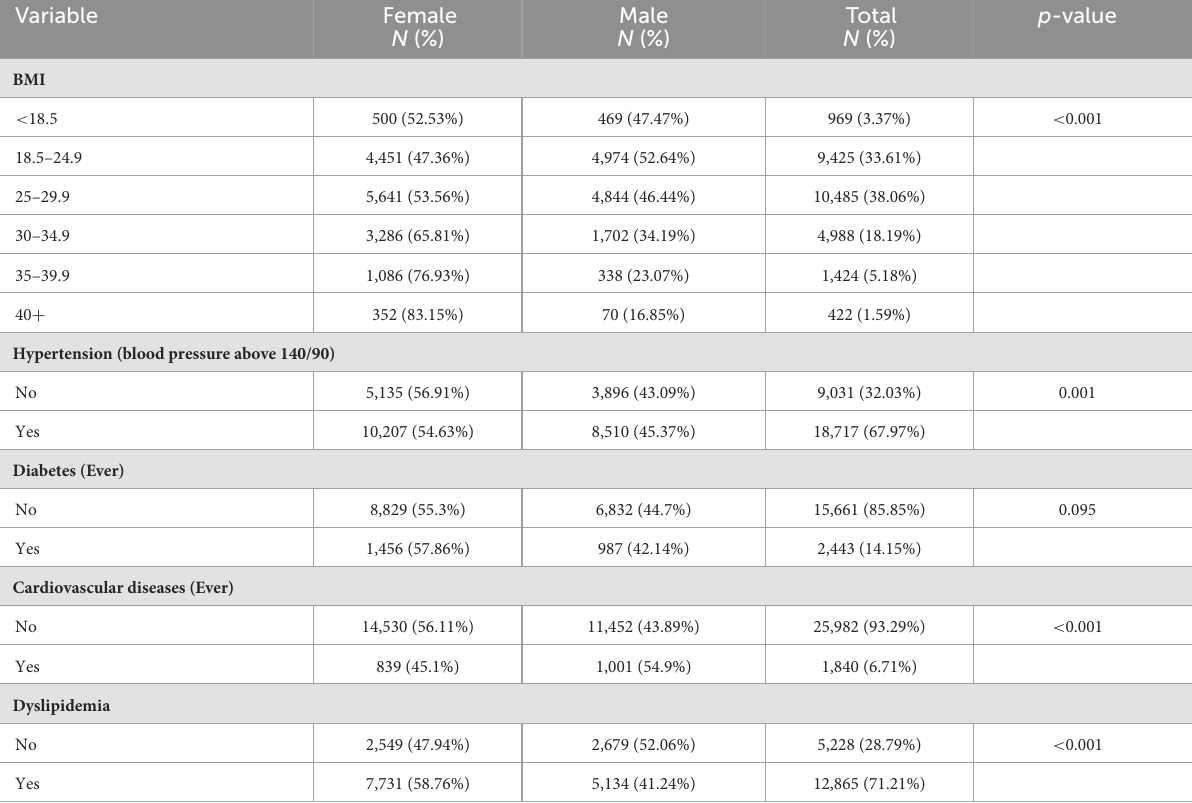
TABLE 2 Prevalence of underlying conditions among